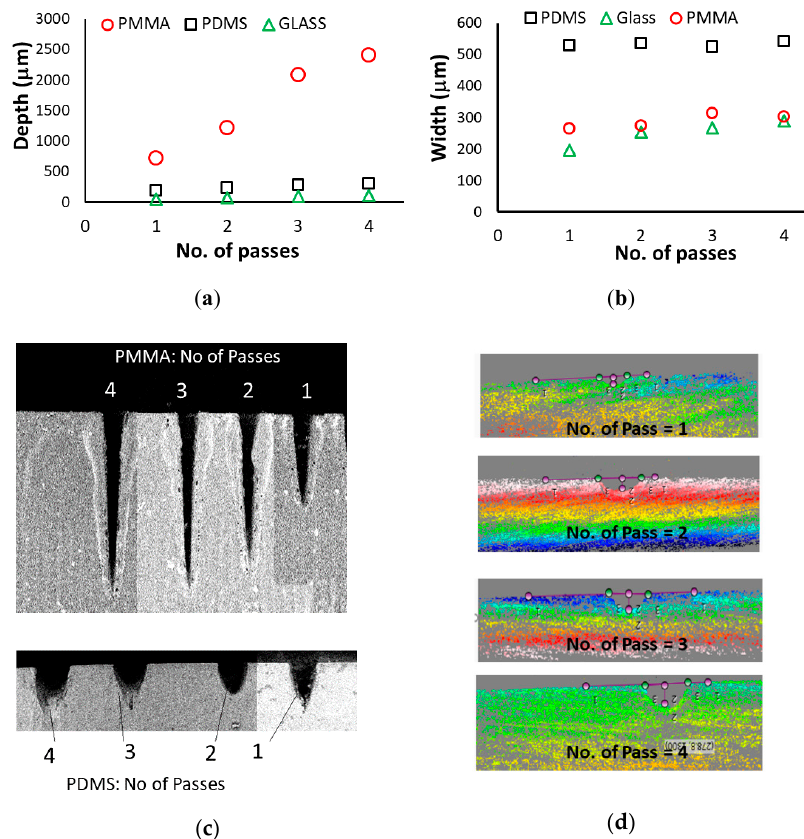
Figure 6. The effect of number of passes on the microchannel characteristics ( a ) depth, ( b ) width of the channels, ( c ) SEM images of PMMA and PDMS channels and ( d ) profilometer images of glass channels.